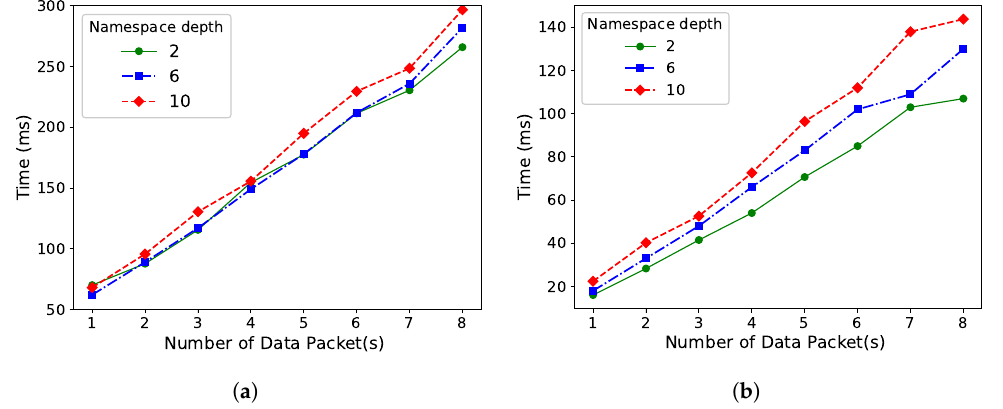
Figure 10. Performance of Publishing/Receiving a Message with Different Namespace Depths and Packet Numbers. ( a ) Publishing with Different Namespace Levels and Packet Numbers. ( b ) Receiving with Different Namespace Levels and Packet Numbers.